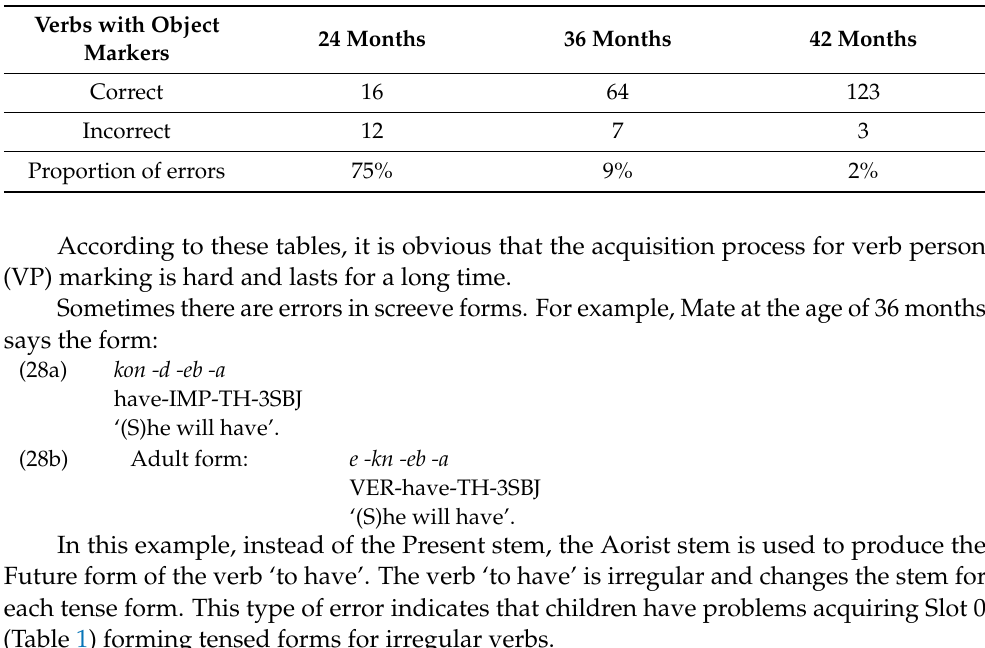
Table 13. The verbs with object